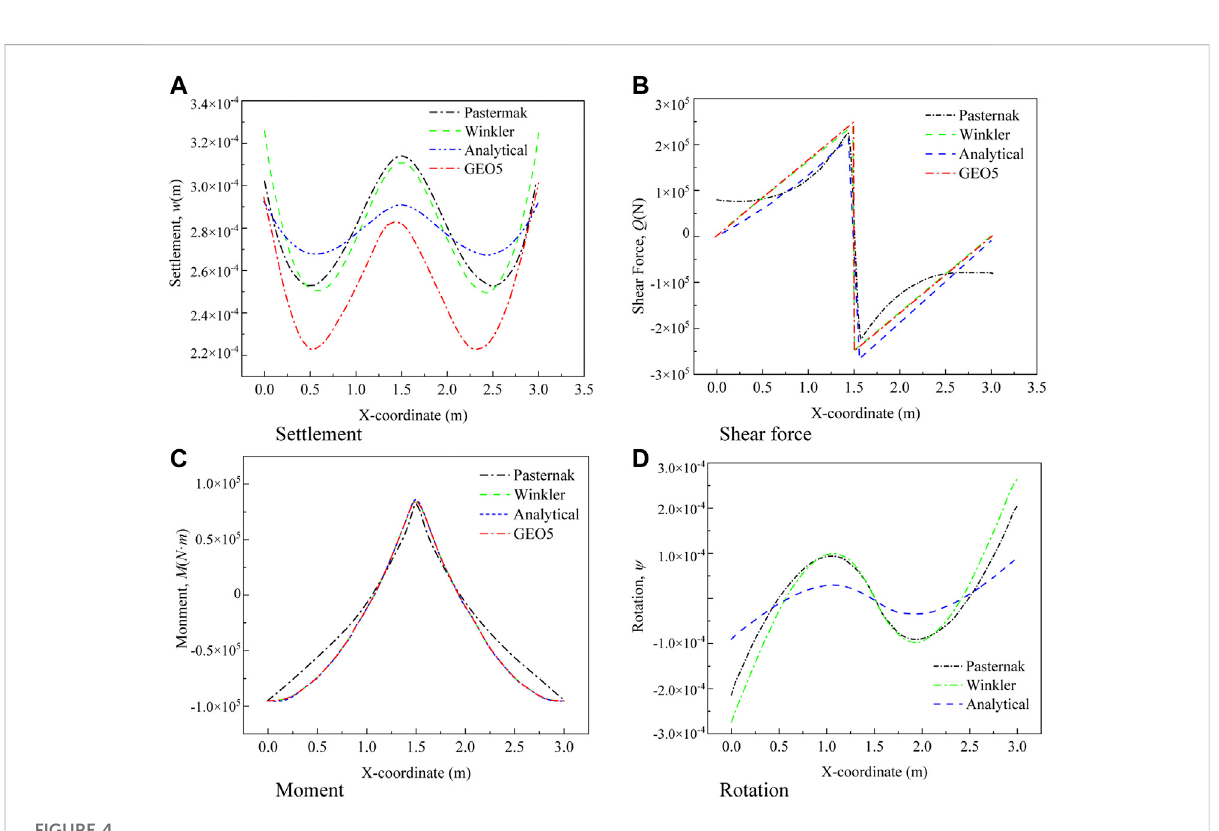
FIGURE 4 Results of the three new methods and